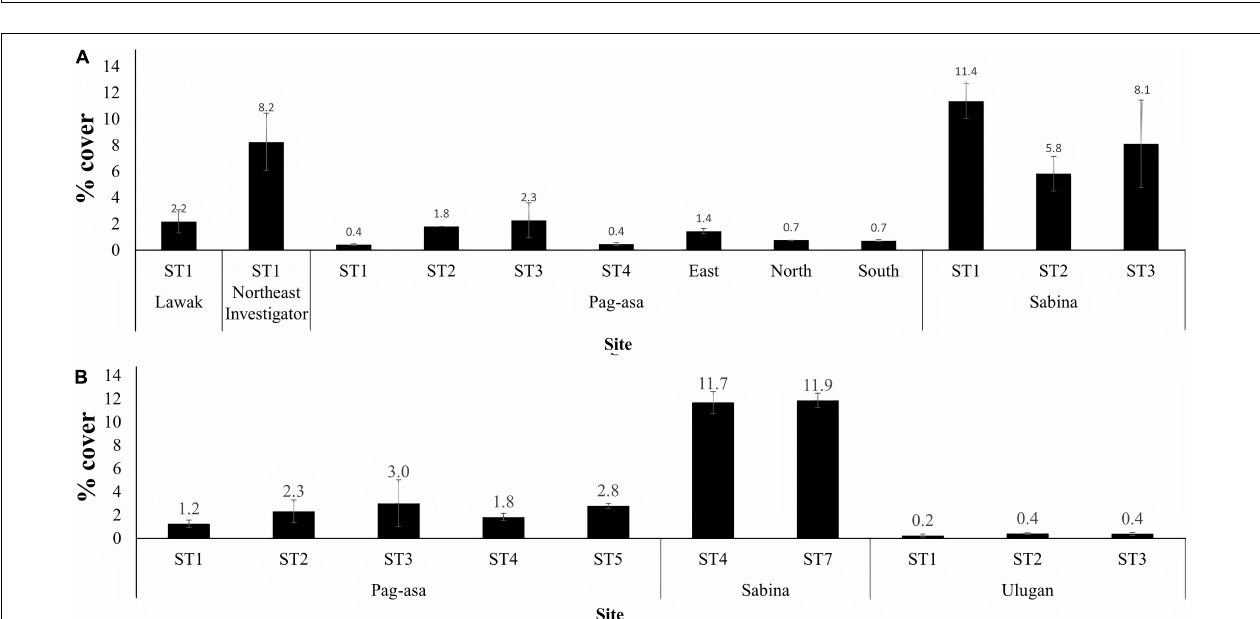
FIGURE 3 | Octocoral cover (mean ± SE) of the stations in the Kalayaan Island Group (Pag-asa, Sabina, Lawak and Northeast Investigator) and Ulugan surveyed in (A) 2017 and (B) 2019. ST denotes station.